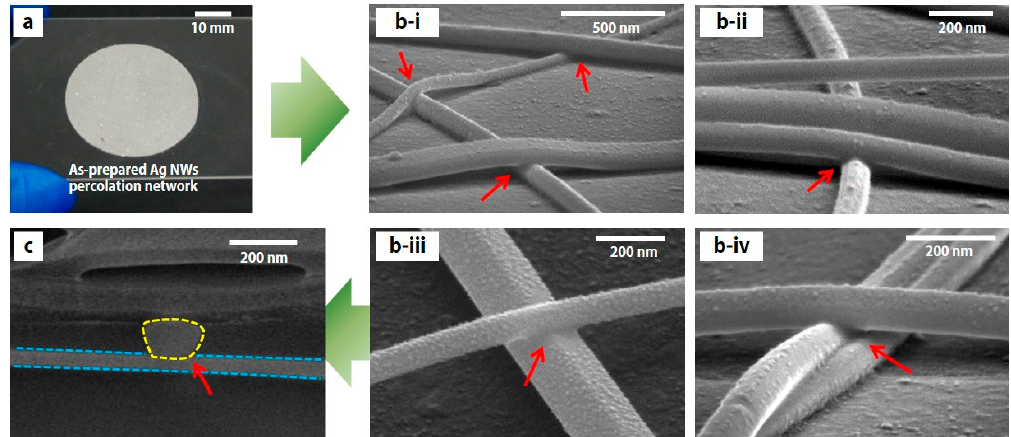
Figure 2. ( a ) Photographic image of the Ag NW percolation networks on the glass substrate (30% transmittance). ( b ) Magnified scanning electron microscope (SEM) images of the Ag NW percolation networks after the laser-induced welding process. ( c ) Cross-sectional SEM image of the junction of the Ag NW percolation networks after the laser-induced welding process. Two Ag NWs are melted and merged at the boundary of two Ag NWs (yellow dots and blue dots). Red arrows represent a junction of Ag NWs in ( b , c ).